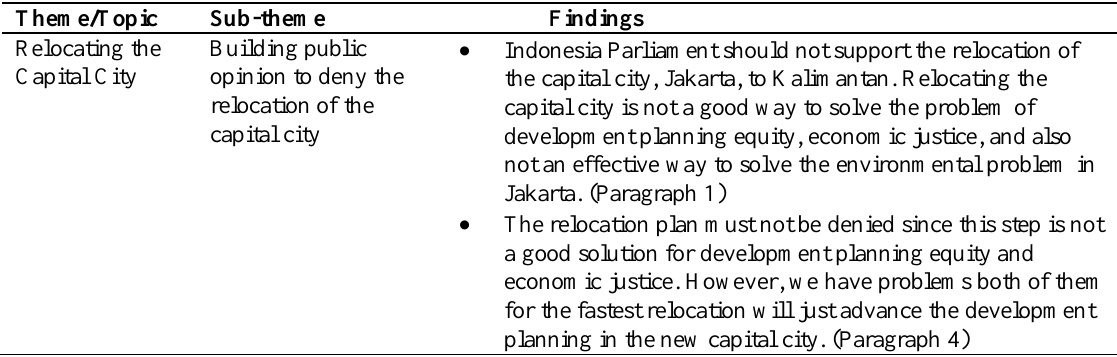
Table 2. Macrostructure